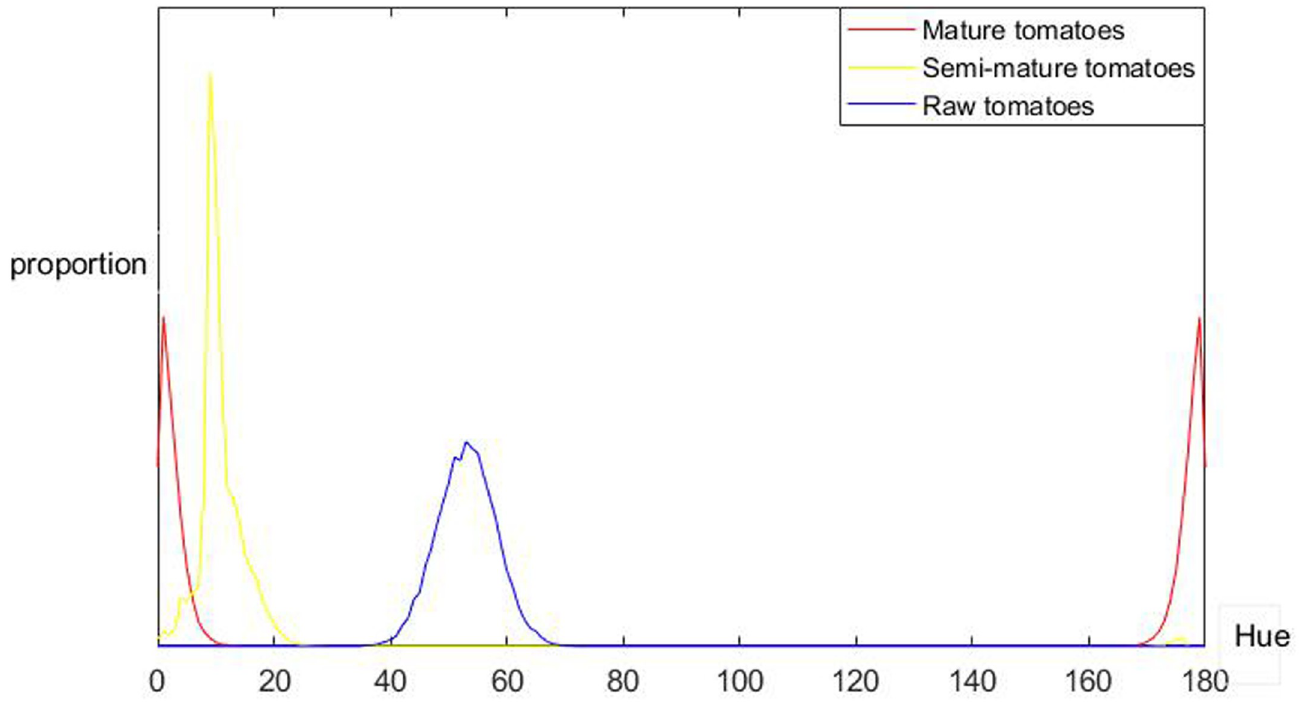
Fig 3. Hue histograms of tomatoes with different maturities.